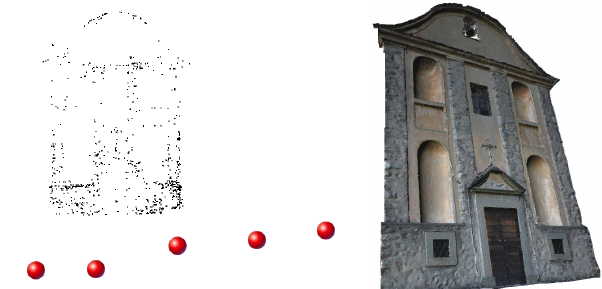
Fig. 4. Orientation results and 3D model from dense matching.